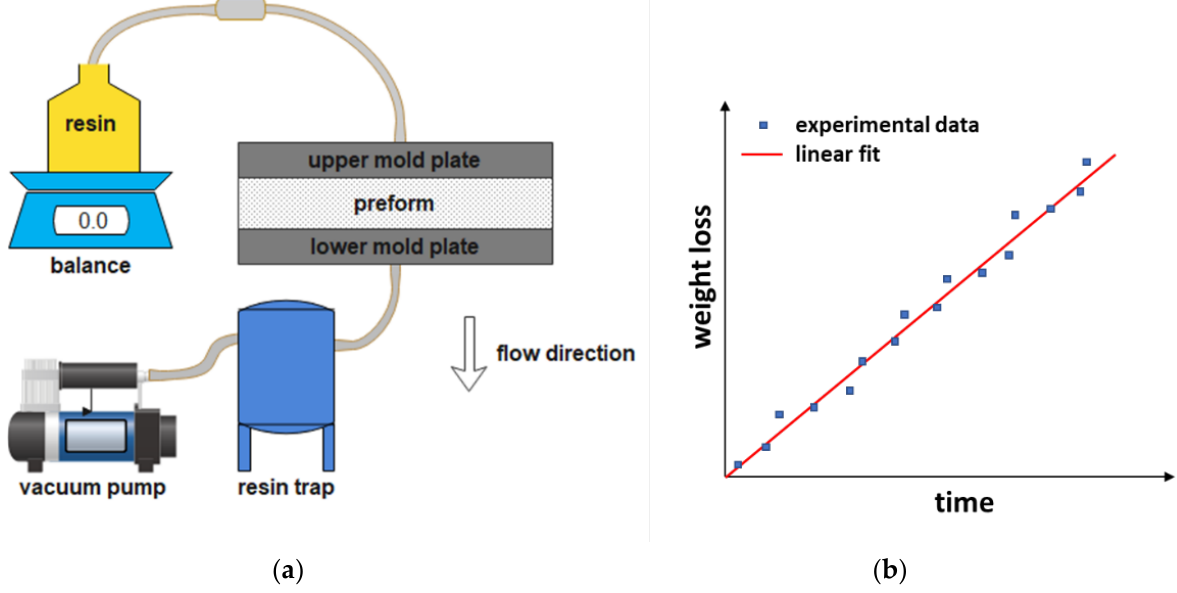
Figure 3. ( a ) Experimental set-up for gravimetric method and ( b ) a typical plot of the weight loss versus time (adapted from Lionetto et al. [52]).